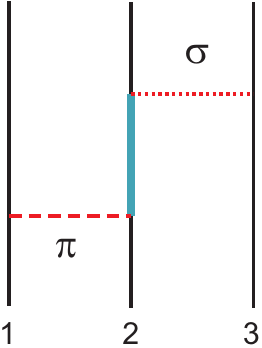
Fig. 3. Born diagram of the pion-sigma exchange three-nucleon force. The vertical solid lines denote